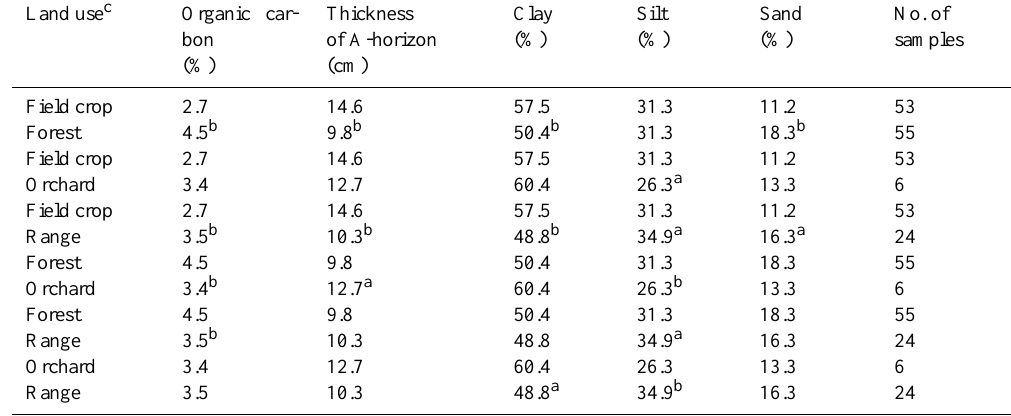
Table 1. Soil properties of lands where the land use has not been changed.